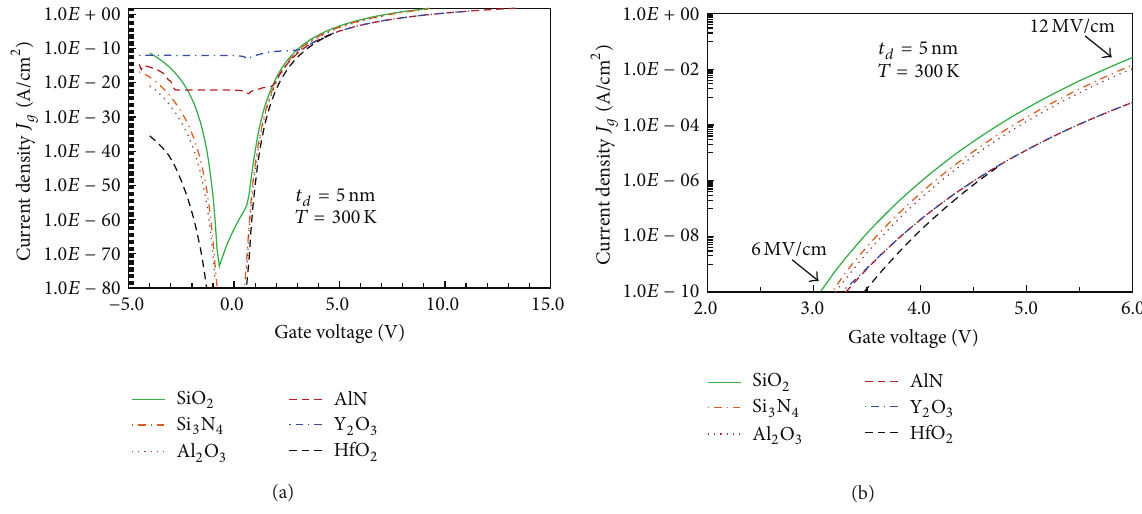
Figure 4: Gate current density as a function of gate bias for various gate dielectrics of thickness 5 nm, each at 300 K (a). Zoomed-in view over limited gate bias range is also shown with an electric field span of 6 to 12 MV/cm